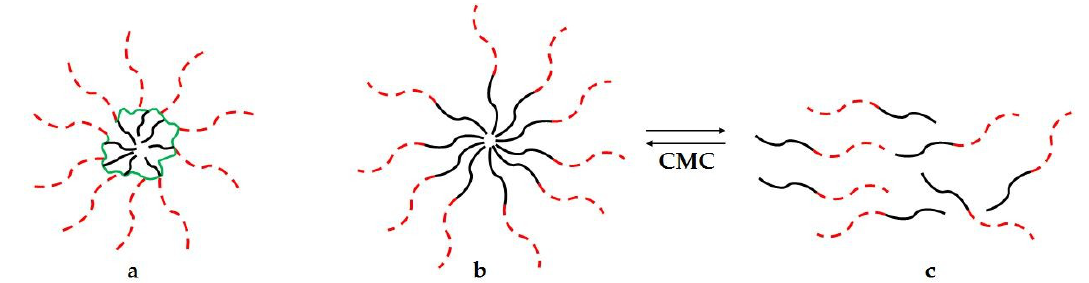
Figure 1. ( a ) Unimolecular micelles in aqueous solution are single‐molecule architectures constituted by a hydrophobic core (black) and a hydrophilic shell (dashed red) covalently linked to a backbone (green); ( b ) conventional polymeric micelles in aqueous solution are an aggregation of amphiphiles having hydrophobic (black) and hydrophilic (dashed red) moieties; and ( c ) at a concentration below Critical Micelle Concentration (CMC), conventional micelles disassemble into free polymeric chains.